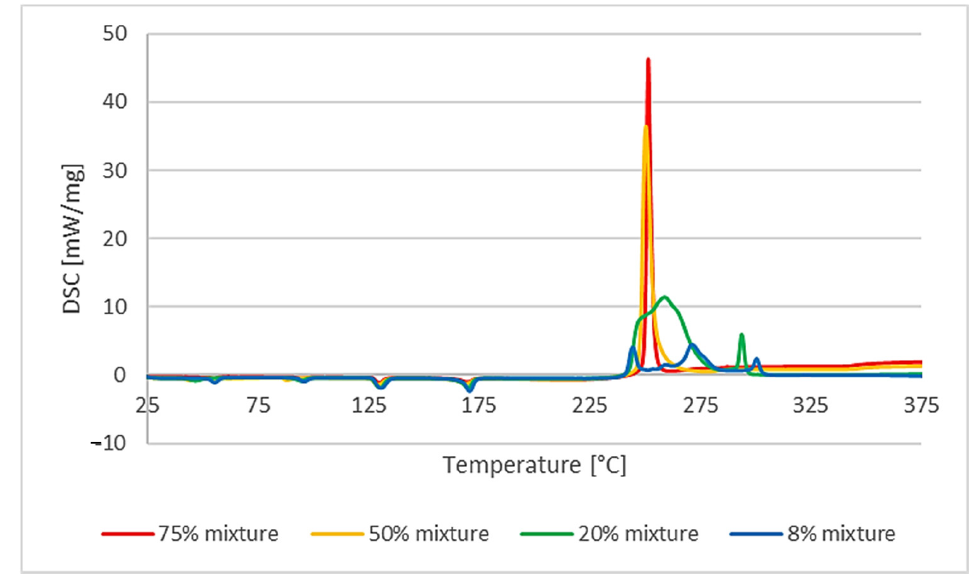
Figure 3. DSC analysis of AN and hard PVC (uPVC) mixture composition influence on their thermal properties, heat rate 10 ◦